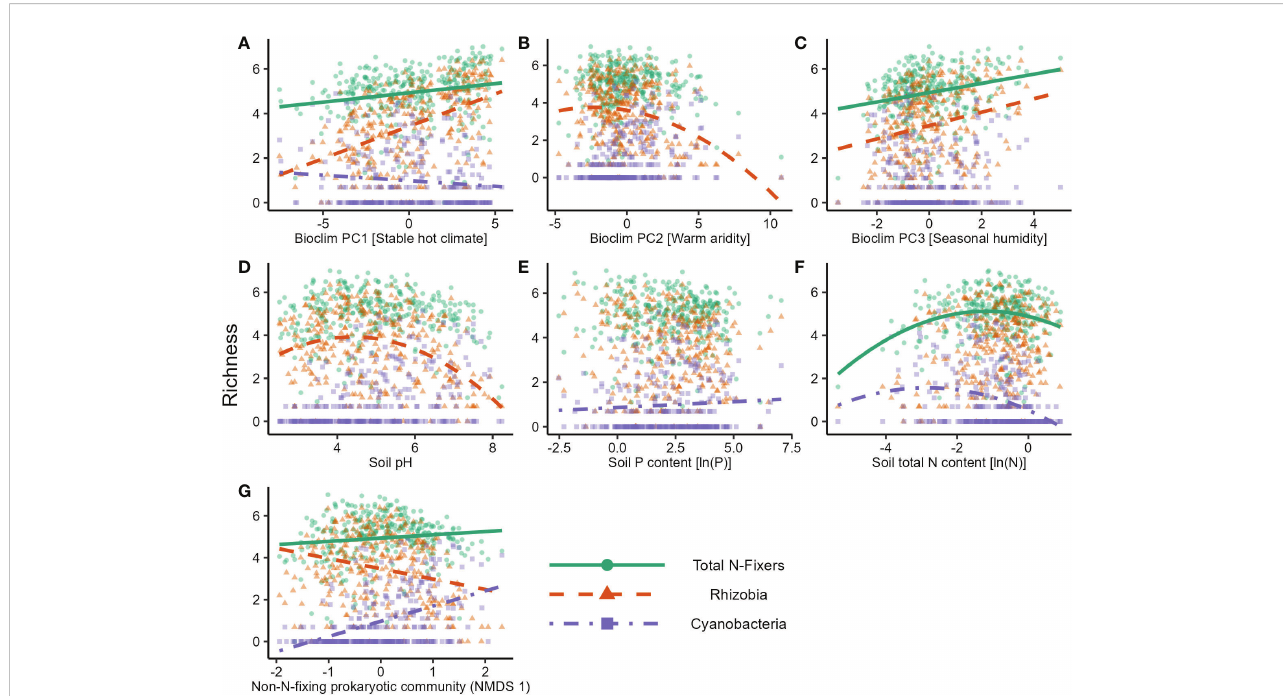
FIGURE 1 Factors affecting the natural logarithm of richness of different groups of N- fi xing prokaryotes in soil samples in the nitrogenase reductase nifH gene dataset. Lines show predicted values from the GLS model. The effects of (A) Bioclim PC1 [Stable hot climate], (B) Bioclim PC2 [Warm aridity], (C) Bioclim PC3 [Seasonal humidity], (D) soil pH, (E) soil P content, (F) soil total N content, and (G) the community composition gradient of the non-N- fi xing prokaryotic community (NMDS axis 1) are